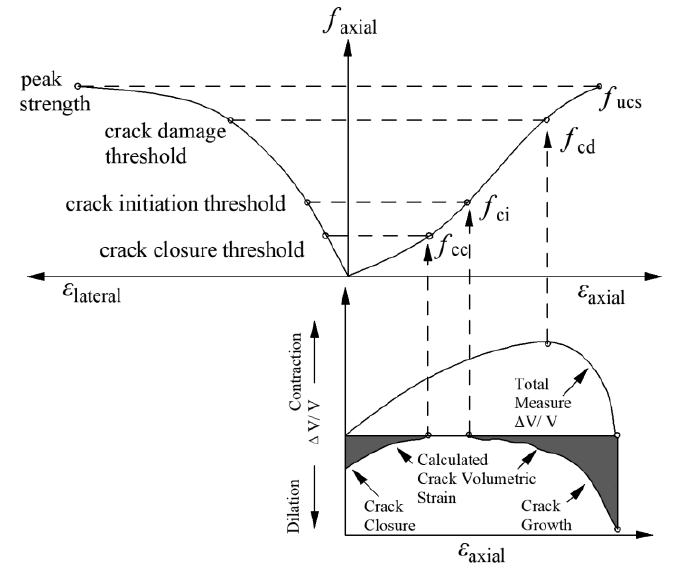
Figure 6. Progressive failure of brittle material (adapted from [28]).